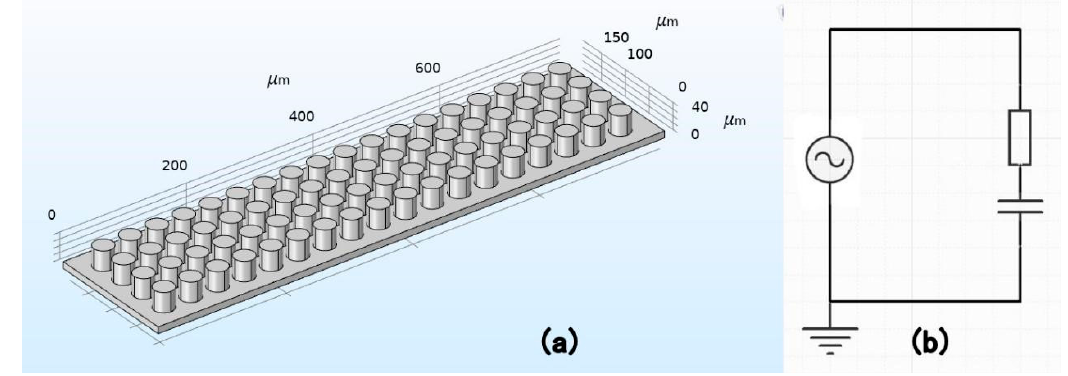
Figure 3. ( a ) Device setting diagram of cylinder modified structure. ( b ) Circuit diagram of the piezoelectric nanogenerator